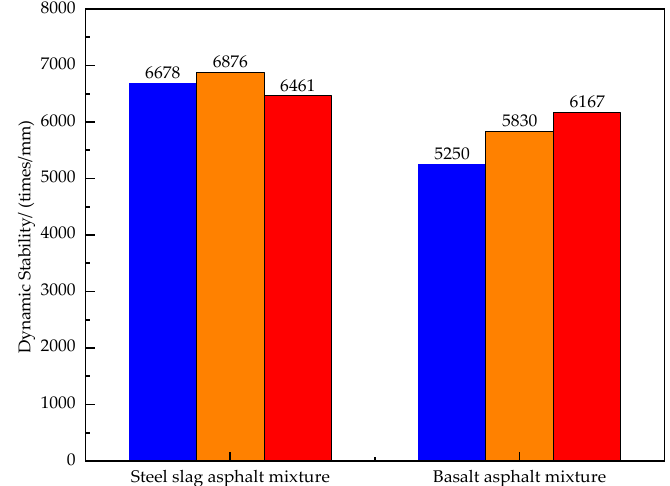
Figure 11. Dynamic stability of two types of asphalt mixture.